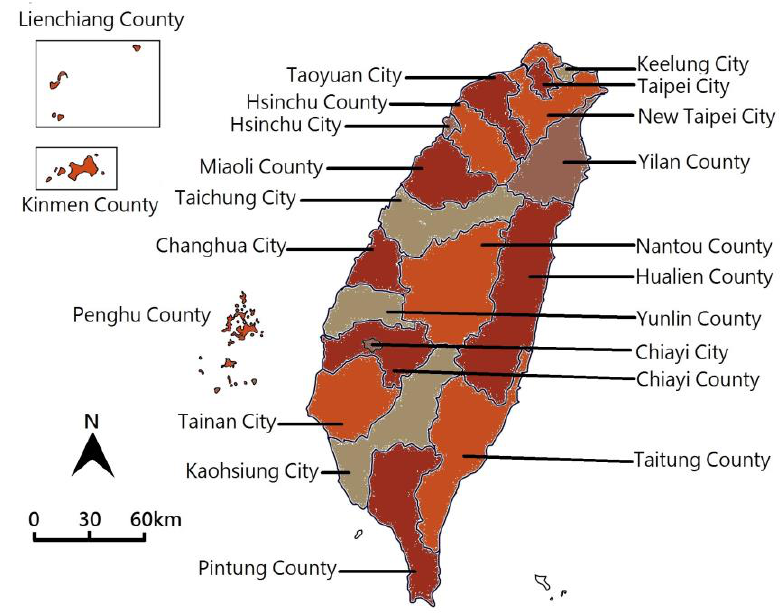
Figure 1. The 22 counties and cities in Taiwan. The map colors have no special meanings.